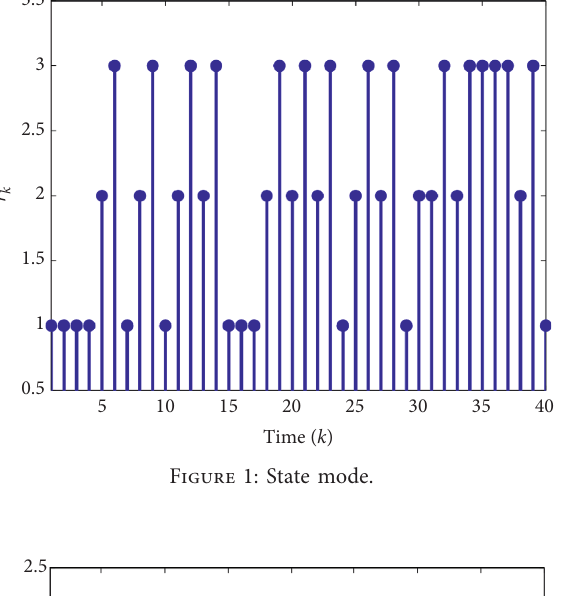
Figure 4: Control input.